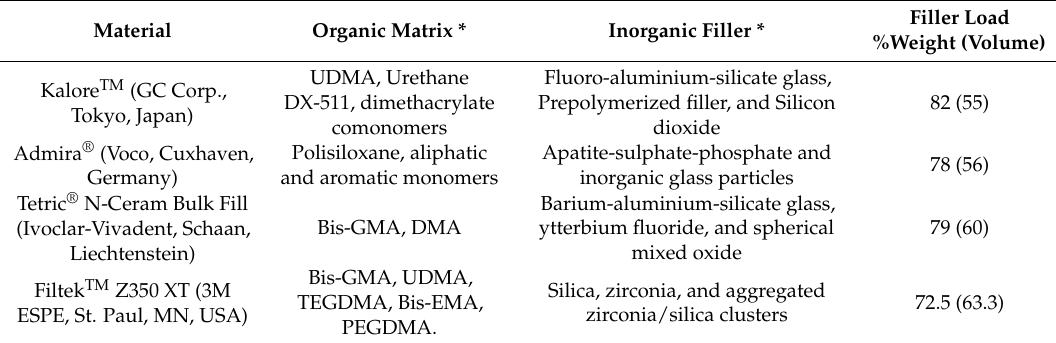
Table 1. Information on the manufacture of the resin-based